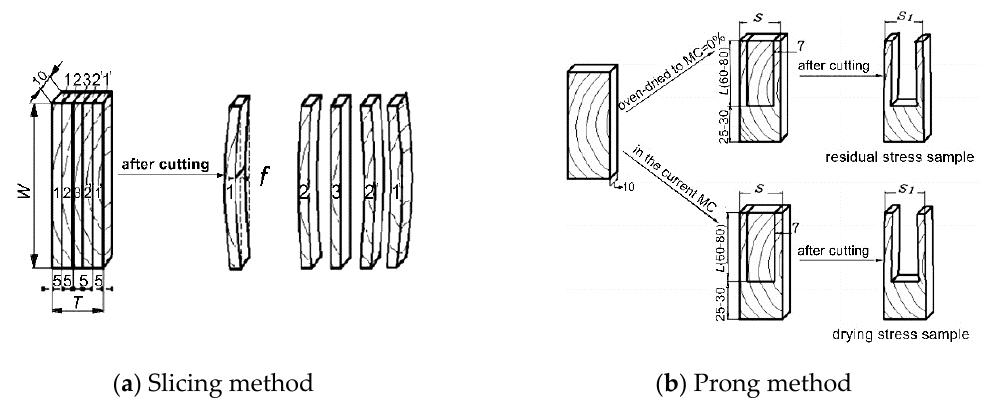
Figure 6. Two commonly used testing methods of drying stress and strain. Dimensions are in mm [44].